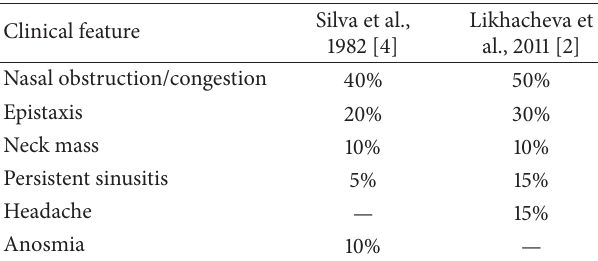
Figure 5: T1 weighted axial MRI demonstrating tumor growth in the cerebellopontine angle. Table 1: Presenting clinical features of sinonasal neuroendocrine